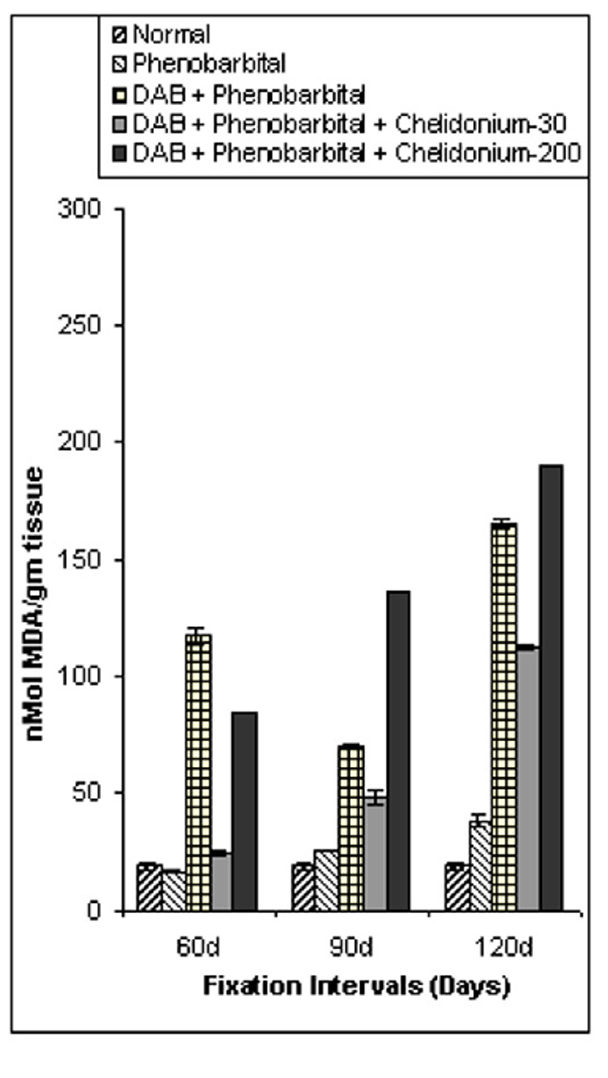
Figure 7 Showing alkaline phosphatase activity in liver of experimental mice at different fixation